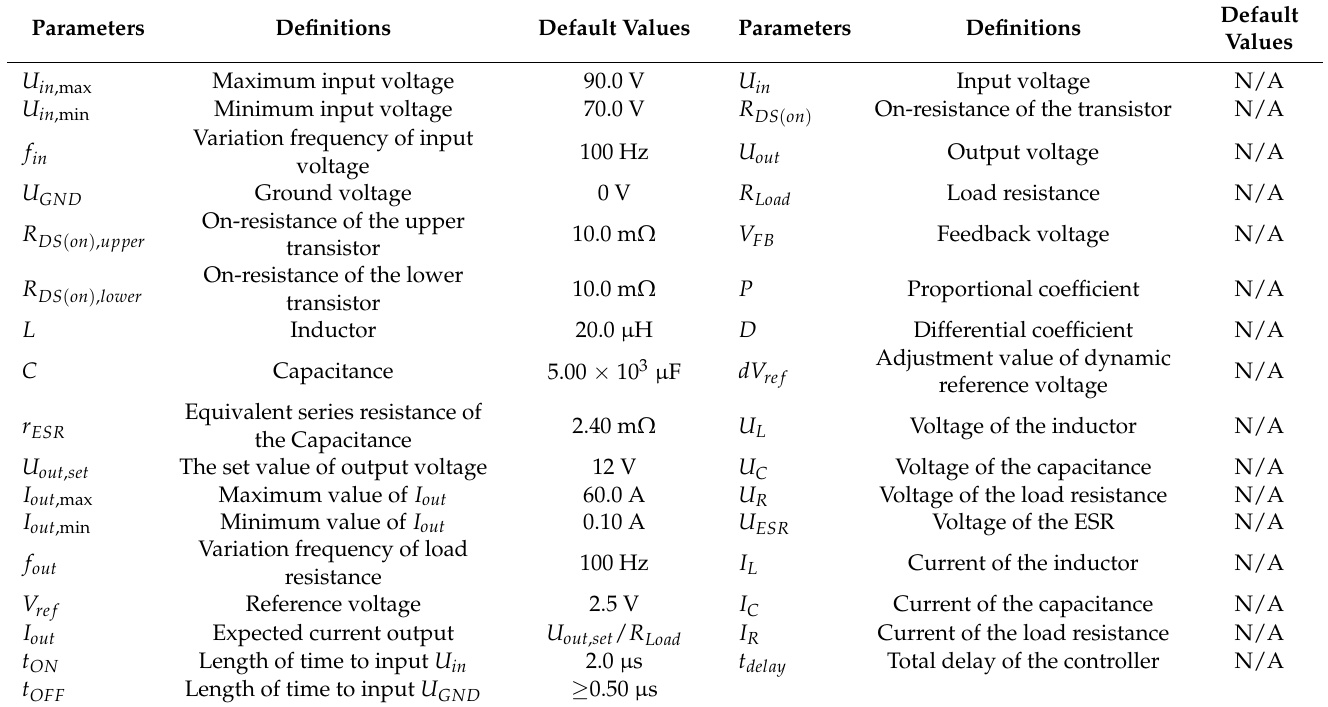
Table 1. The definitions of the